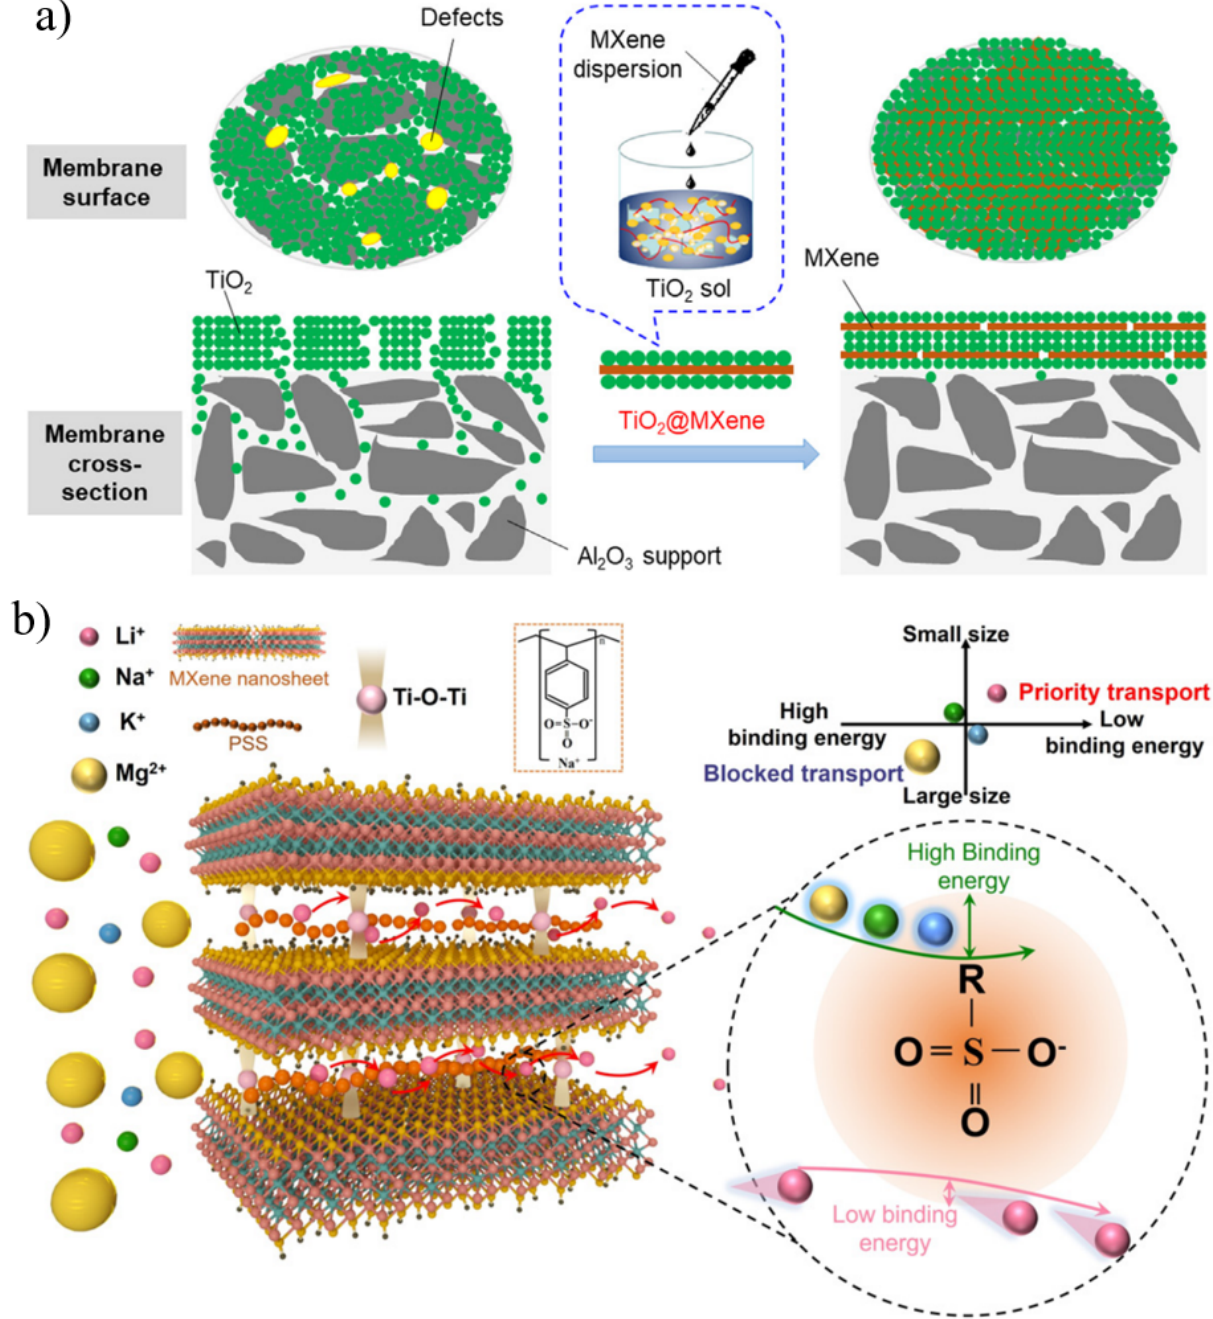
Figure 9. ( a ) Fabrication of TiO 2 -MXene membranes to eliminate potential defects. ( b ) Diagrammatic sketch of the fast transport subnanochannels for Li + in MXene/PSS composite membranes. Reprinted with permission from [124,125]. Copyright (2018) Published by Elsevier B.V. Copyright (2021) Published by Wiley-VCH GmbH.